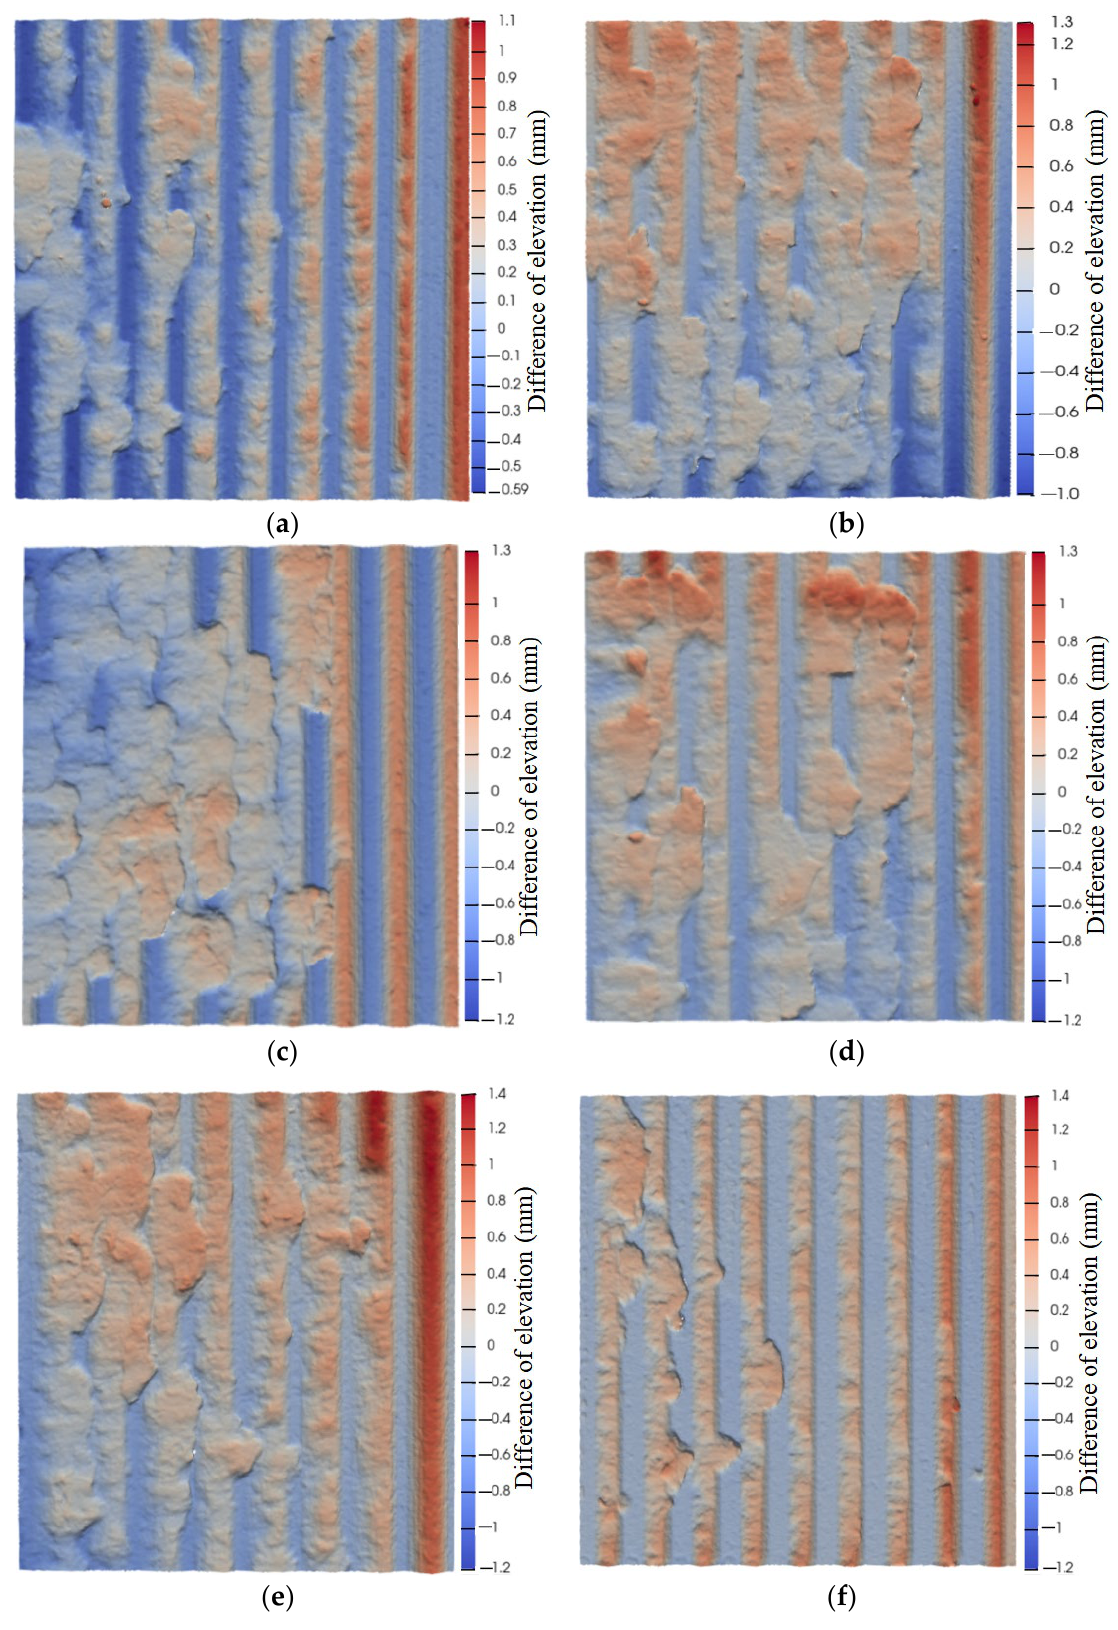
Figure 16. Shear fracture characteristics of a structural plane with a 40° undulating angle. ( a ) 40-1; ( b ) 40-2 ; ( c ) 40-3 ; ( d ) 40-4 ; ( e ) 40-5 ; ( f ) 40-6.